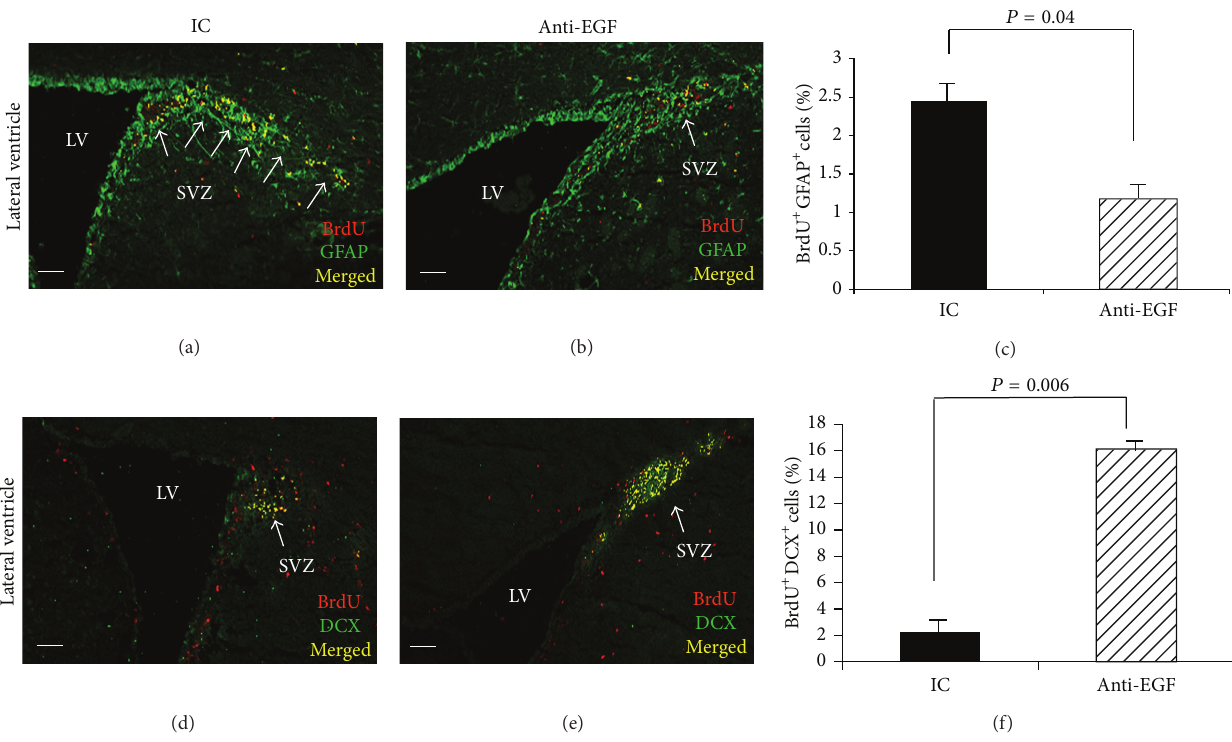
Figure 2: Reduced numbers of NSCs and increased numbers of neuroblasts in the SVZ in response to therapy with anti-EGF Ab. Immunohistochemical labeling of BrdU + GFAP + cells and BrdU + DCX + cells in the SVZ of IC-treated mice (a and d, resp.) and of anti- EGF Ab-treated mice (b and e, resp.) on day 18 after immunization. Quantification of %BrdU + GFAP + cells (c) and of %BrdU + DCX + cells (f) revealed reduced numbers of BrdU + GFAP + cells and increased numbers of BrdU + DCX + cells in the SVZ of anti-EGF Ab-treated EAE mice compared to IC-treated mice. Images were obtained using a confocal microscopy, coronal sections. Quantification was performed using ZEN 2011 software on 3 sections from each mouse (3 mice from each group, total 𝑛 = 9 ). LV , lateral ventricle, SVZ , subventricular zone. Scale bar: 100 𝜇